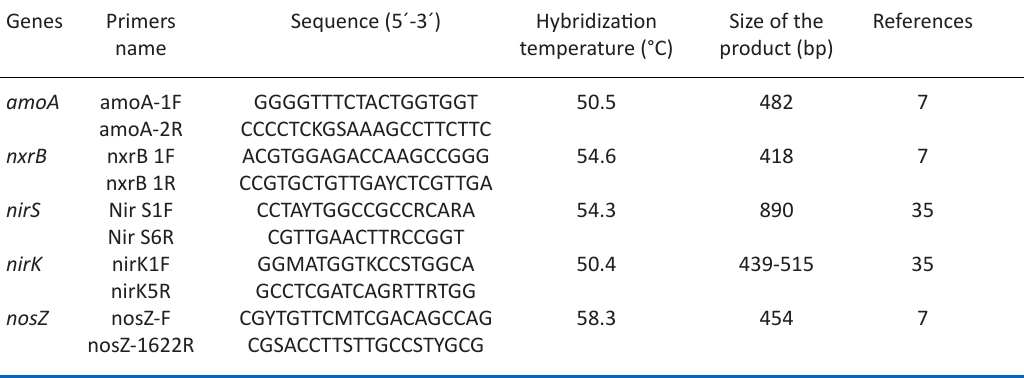
Table 1. List of primers used for the identification of genes related to nitrification and denitrification Genes Primers Sequence